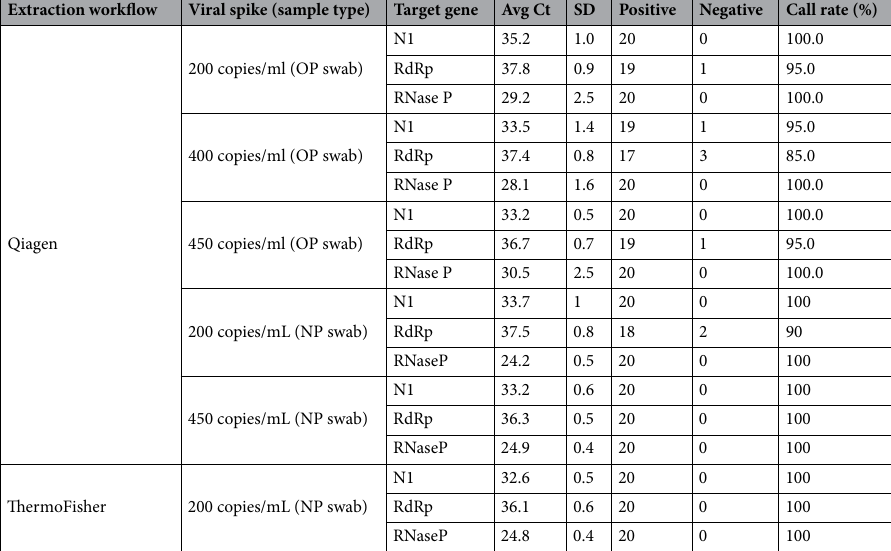
Table 2. LoD confirmation of workflow sensitivity for N1 and RdRp with Qiagen QIAamp™ Viral RNA mini kit (OP and NP swabs) and ThermoFisher MagMAX™ Viral/Pathogen Nucleic Acid Isolation Kit (NP swabs).